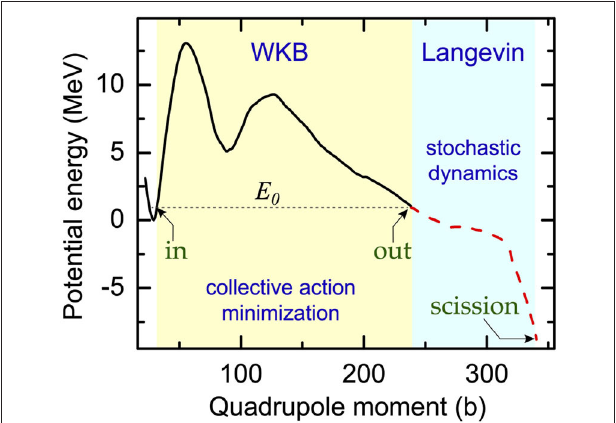
FIGURE 1 | Variation in potential energy calculated along the most-probable fission path of 240 Pu. The region marked as WKB is classically forbidden as the fission excitation energy E 0 is less than the potential energy. Shape evolution: the collective action is minimized between the turning points “in” and “out” by using the WKB method and, from “out” to scission, dynamics is governed by Langevin dynamics. The figure is adapted from Sadhukhan et al.